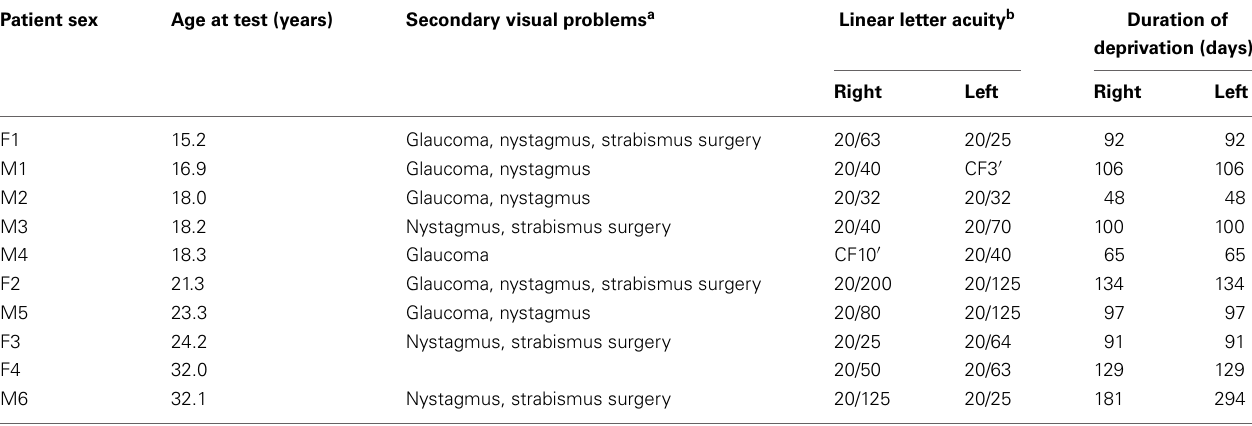
Table 1 | Details of the 10 patients treated for bilateral congenital cataract.